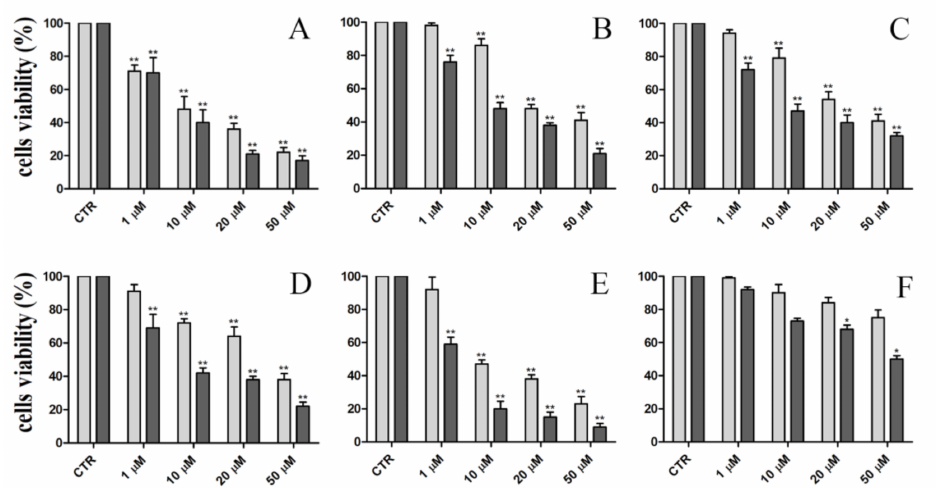
Figure 3. Cell viability of HT-29 ( A ), MDA-MB231 ( B ), U-87 MG ( C ), FaDu ( D ), CAL 27 ( E ), HF ( F ) untreated (CTR) and treated with compound 2a at 1, 10, 20, 50 µ M for 24 h (light gray) and 48 h (dark gray). The values are expressed as percentages of alive cells ± SD. * p < 0.01; ** p <